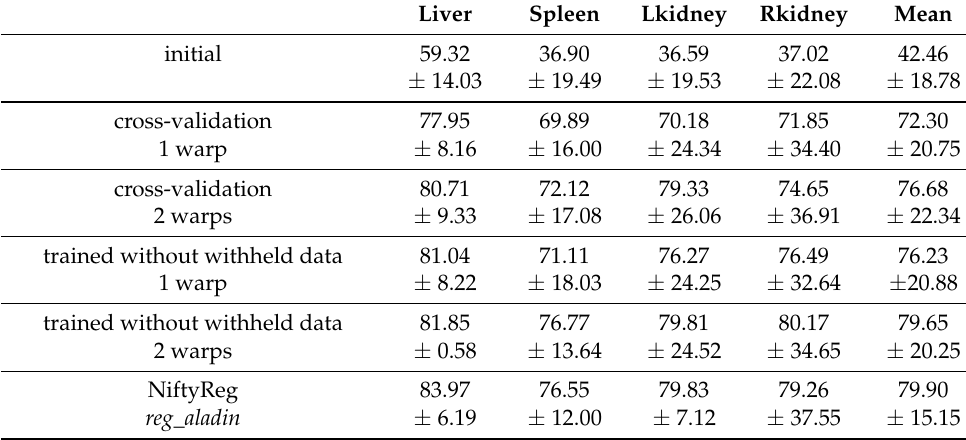
Table 2. Results for our experiments comparing single-level and two-level warping approach as well as cross-validation and training without withheld data: Dice scores listed by anatomical structures of our experiments using Cycle Discrepancy for